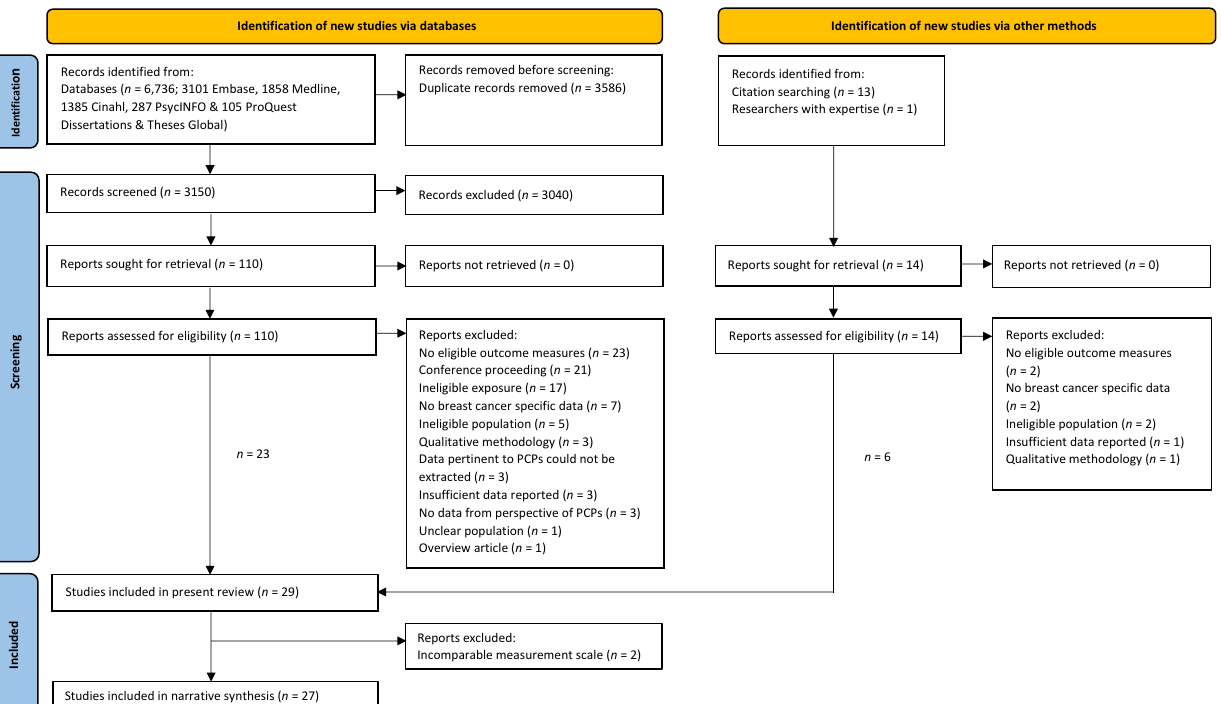
Identification of new studies via databases